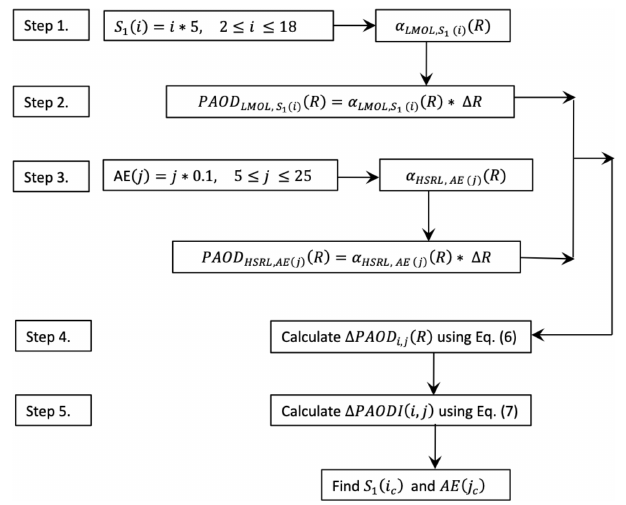
Figure 3. Flow chart of the process of calculating the 292nm S 1 and the AE between 532 and 292nm. i is the integer increment from 2 to 18 that was used to calculate S 1 in order to make S 1 vary from 10 to 90. j is the integer increment from 5 to 25 that was used to calculate the AE in order to make the AE vary from 0.5 to 2.5. i and j could also be the index of the calculated partial